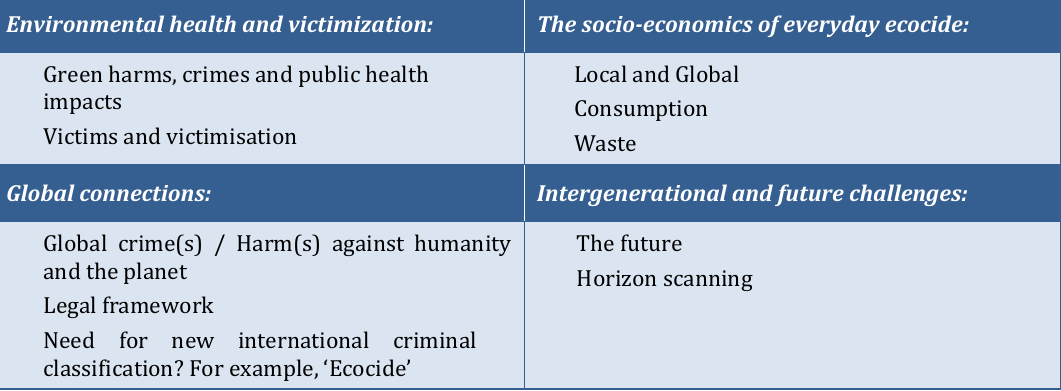
Figure 2: Author’s typology of a green criminology (representing dimensions of space and time) Environmental health and